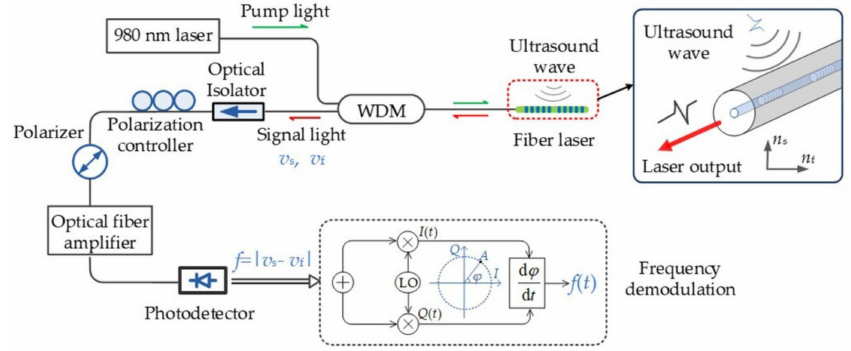
Figure 2. Ultrasound wave detection and signal demodulation based on the fiber laser sensor. Figure adapted with permission from Ref. [43].